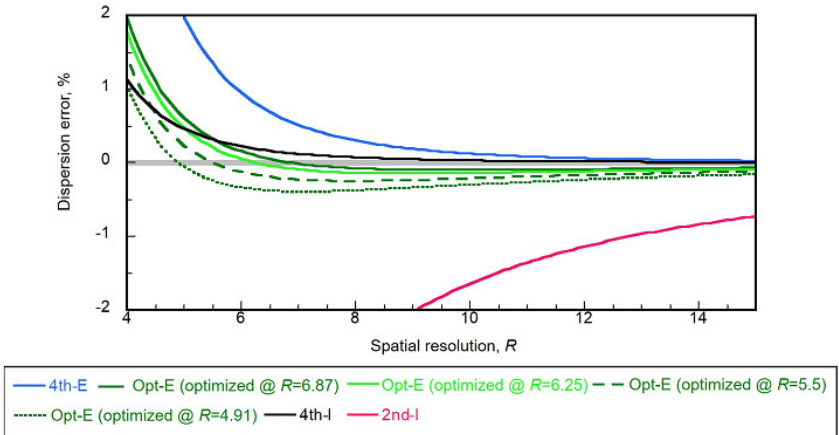
Figure 1. Dispersion errors of 4th-E and Opt-E TD-FEMs compared to 4th-I and 2nd-I TD-FEMs. The comparison is made as a function of the spatial resolution. Opt-E TD-FEMs use four optimized conditions in which the dispersion error is minimized at different spatial